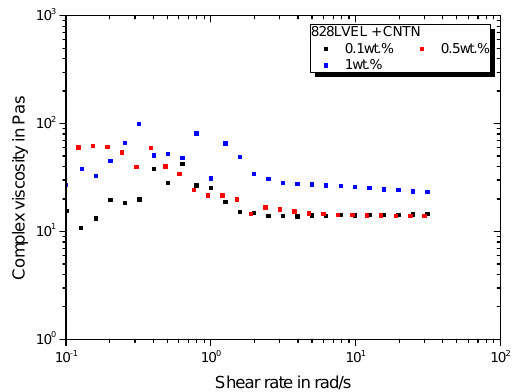
Figure 6. Rheological behavior of CNTN modified 828LVEL and RIMH137/134.